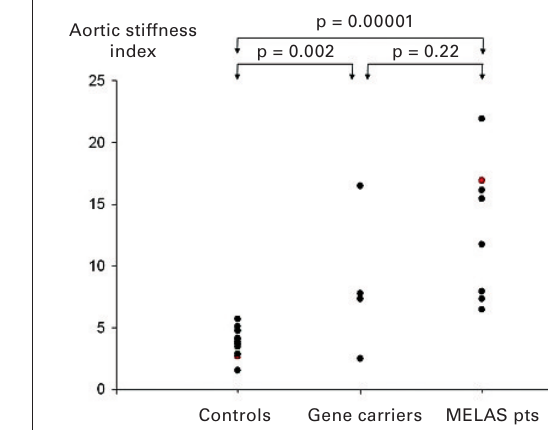
Individual β indices of MELAS patients, gene carriers and control subjects.